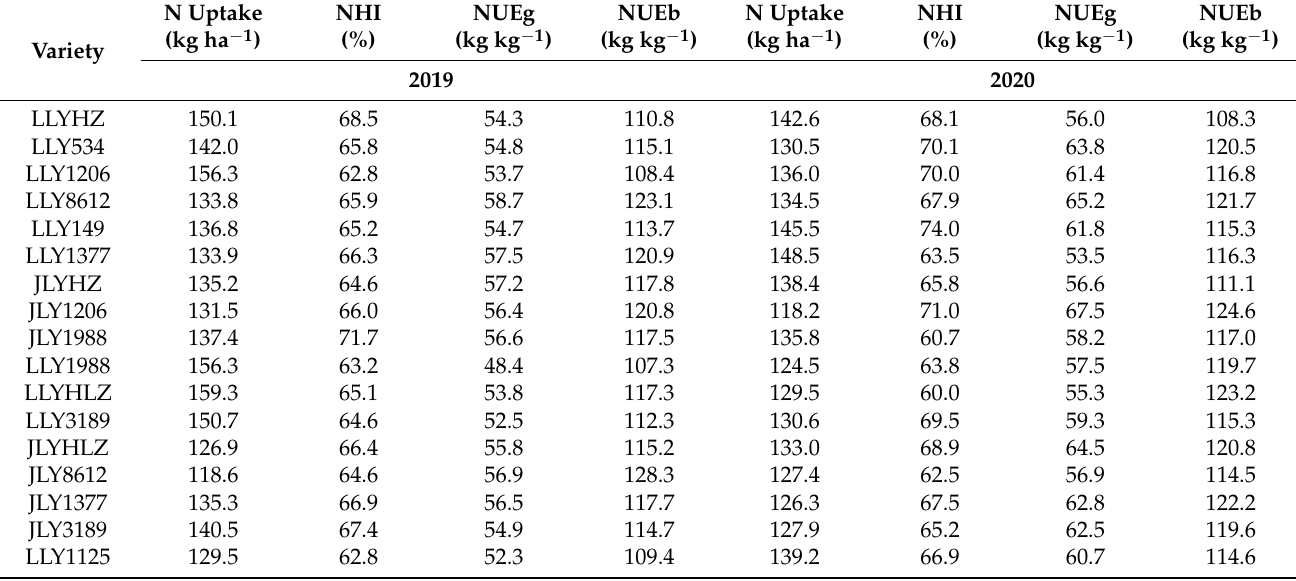
Table 3. Nitrogen use efficiency of tested hybrid rice varieties in 2019 and